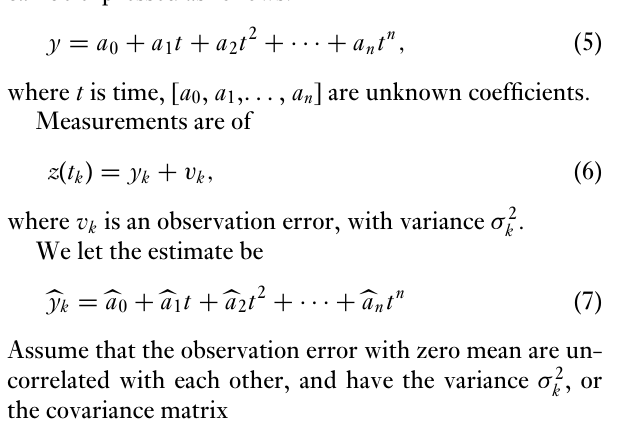
Figure 8 Linear–non-linear combinational